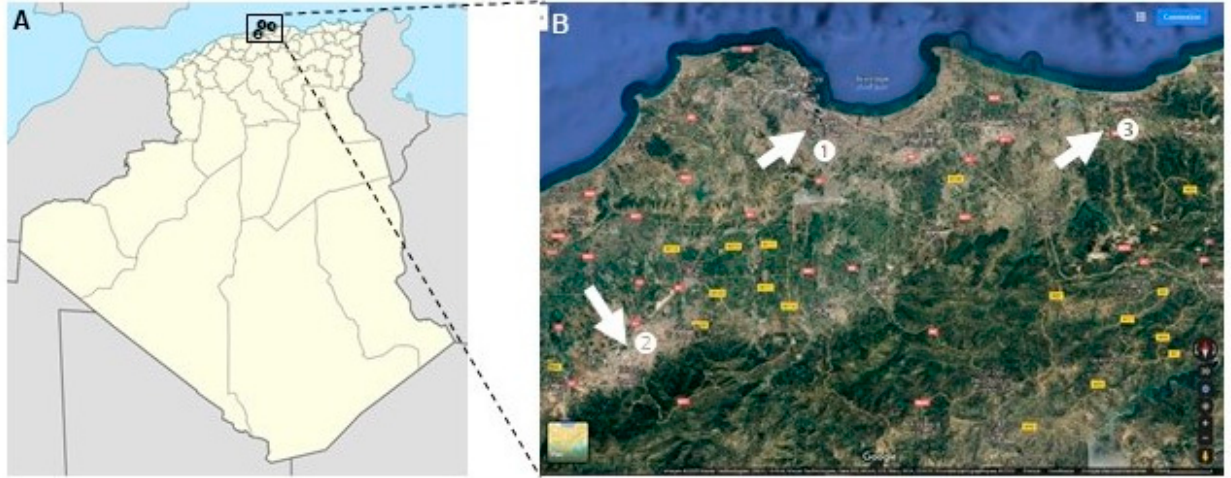
Figure 1. Regions of sampling for the study. ( A ) Blood of hunting dogs were collected in Algiers (1; 273 km 2 , population: 2,947,461), Blida (2; 1696 km 2 , population: 1,009,892) and Boumerdes (3; 1591 km 2 , population: 795,019) regions (black dots). ( B ) Regions 2 and 3 are surrounded by mountain landscapes and region 1 is suburban with forests and fields (white arrows, Blida is southwest of Algiers, and Boumerdes is east of Algiers, Satellite image provided by GoogleMap, Map data: Google, Maxar Technologies, as indicated).